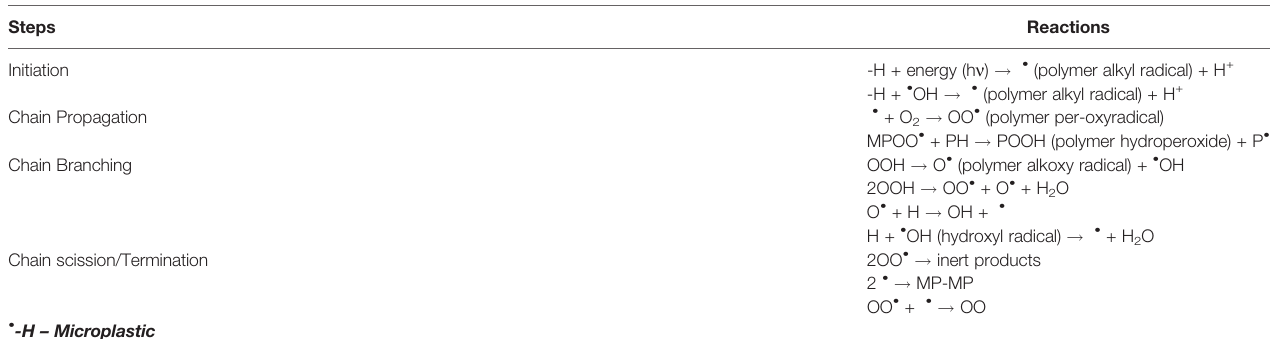
TABLE 2 | The general mechanism of photocatalytic degradation of